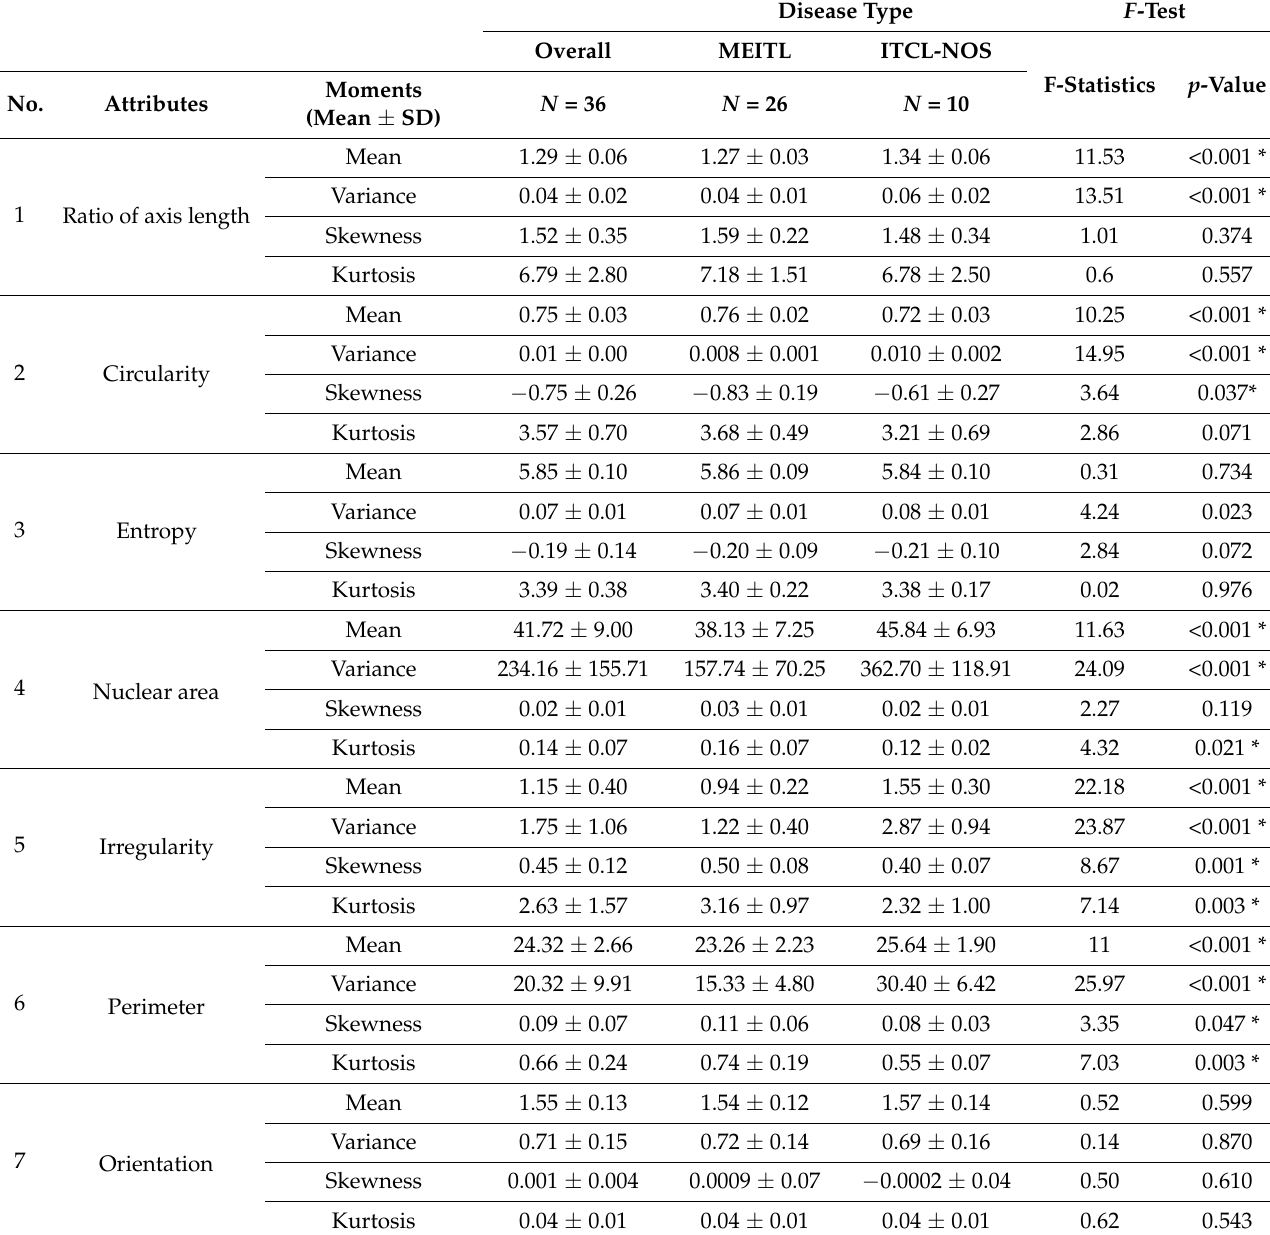
Table 5. Characteristics of the computed cellular morphometrics between cases of MEITL and ITCL-NOS. (* p < 0.05).